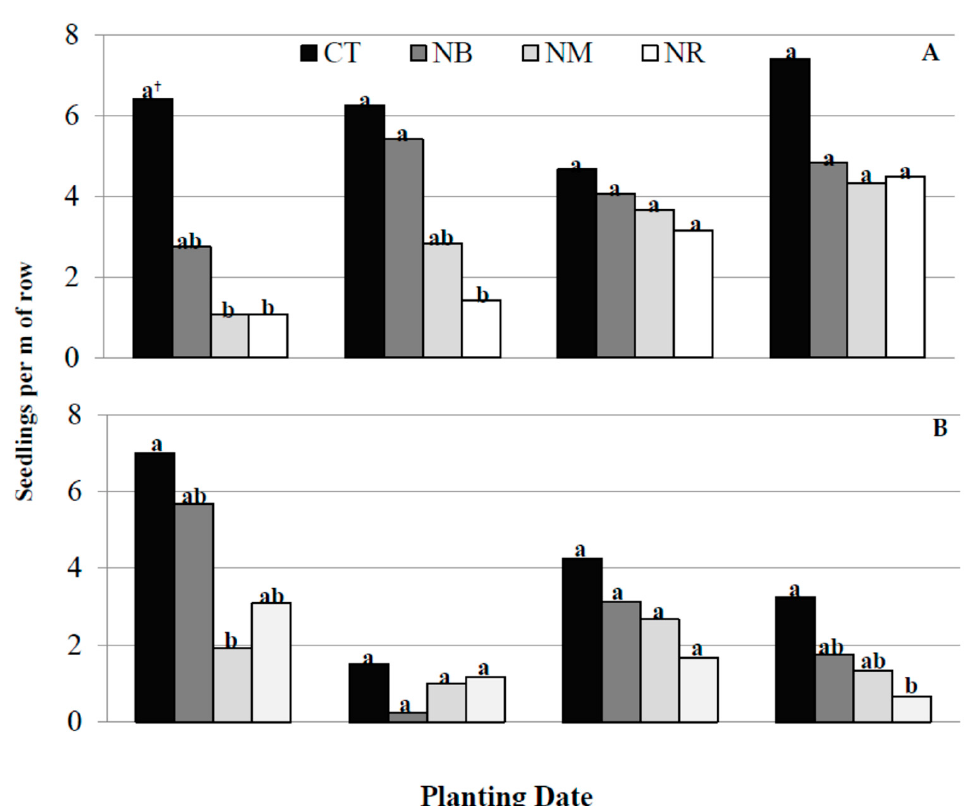
Figure 3. † Means within the same planting date sharing the same letters but are not statistically different according to Fisher’s protected LSD ( p < 0.05). Seedlings per m of row of the hybrid turnip 14 days after planting for the 1 September (S1), 15 September (S15), 1 October (O1), and 15 October (O15) planting dates for each land preparation method: conven- tional tillage (CT), NB, NM, and NR. For the 2016–17 growing season ( A ) and the 2017–18 growing season ( B